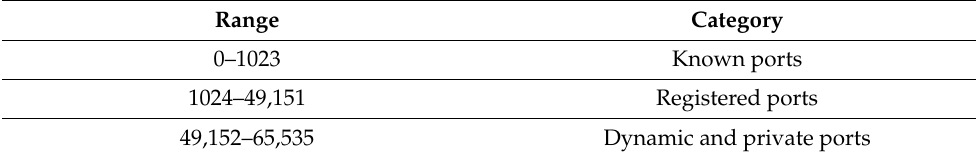
Table 21. Port range of communication ports.